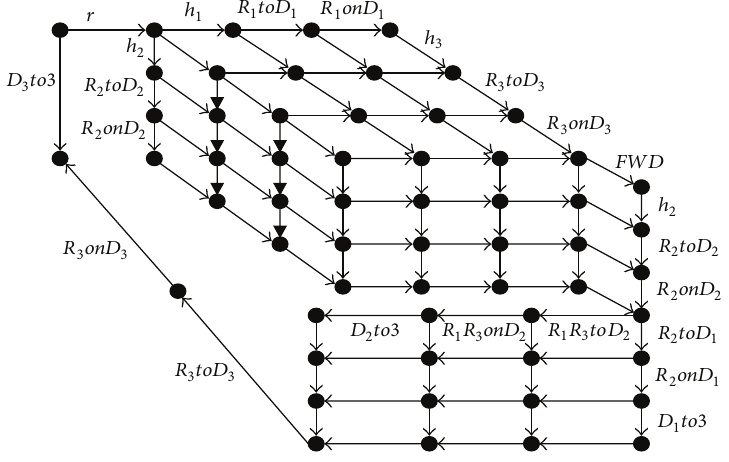
Figure 3: Task automata.